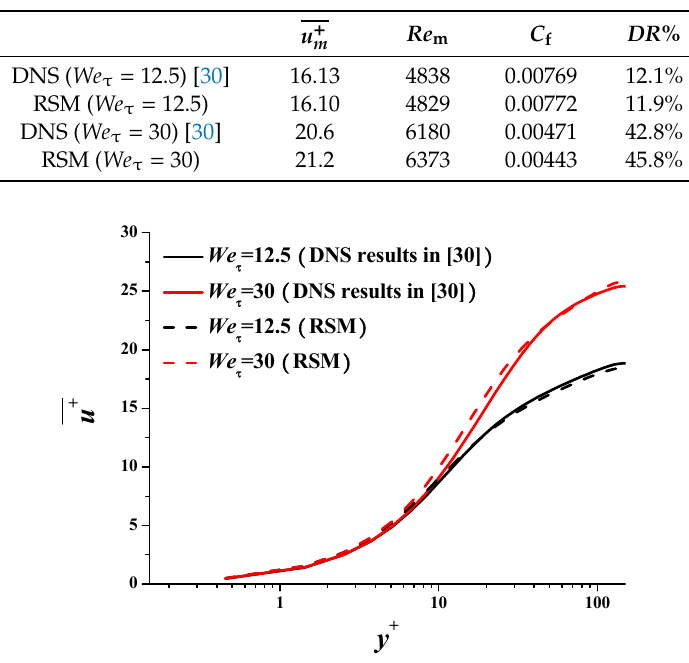
Figure 6. Mean velocity profile comparison with literature.